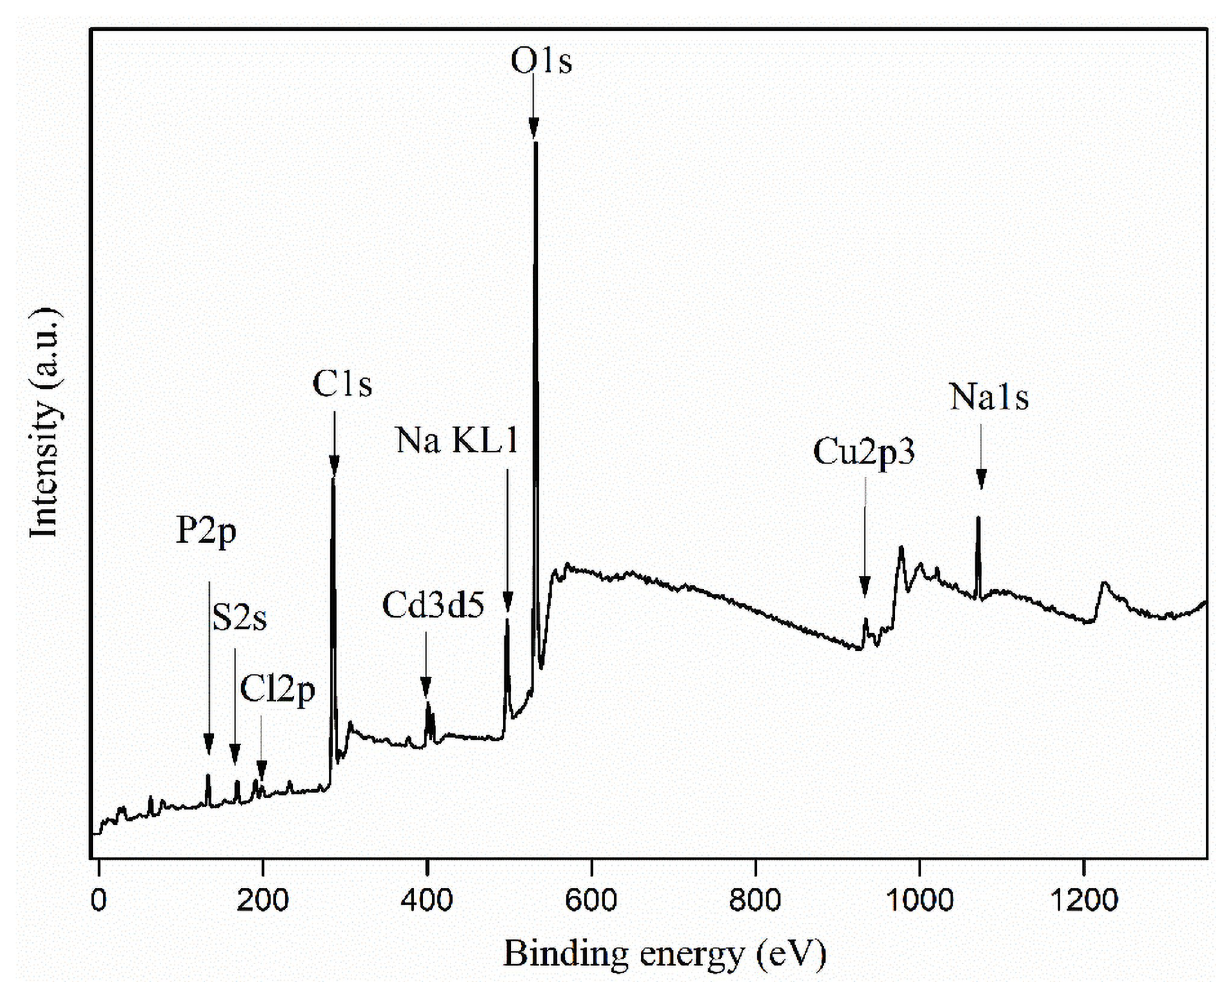
Fig 6. XPS survey spectra for the industrial waste